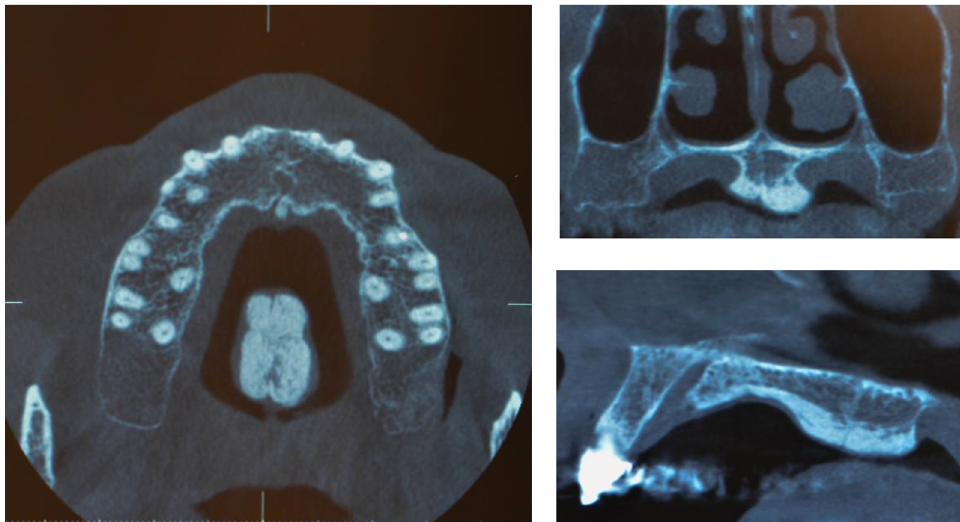
Fig. 2. Preoperative computed tomography scan of a posterior palatal torus (patient T).